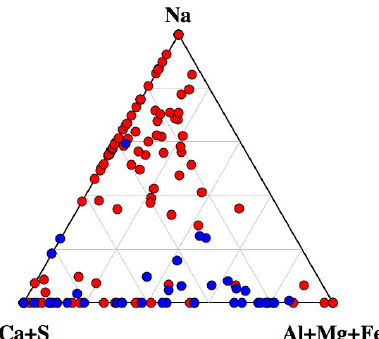
Figure 8. Ternary diagram of Na–(Ca + S)–(Al + Mg + Fe) compo- nents, showing the compositions of all particles analyzed by SEM- EDX analysis. Data are presented in relative atomic proportions. The circles indicate the non-active (red) and IN active particles (blue).